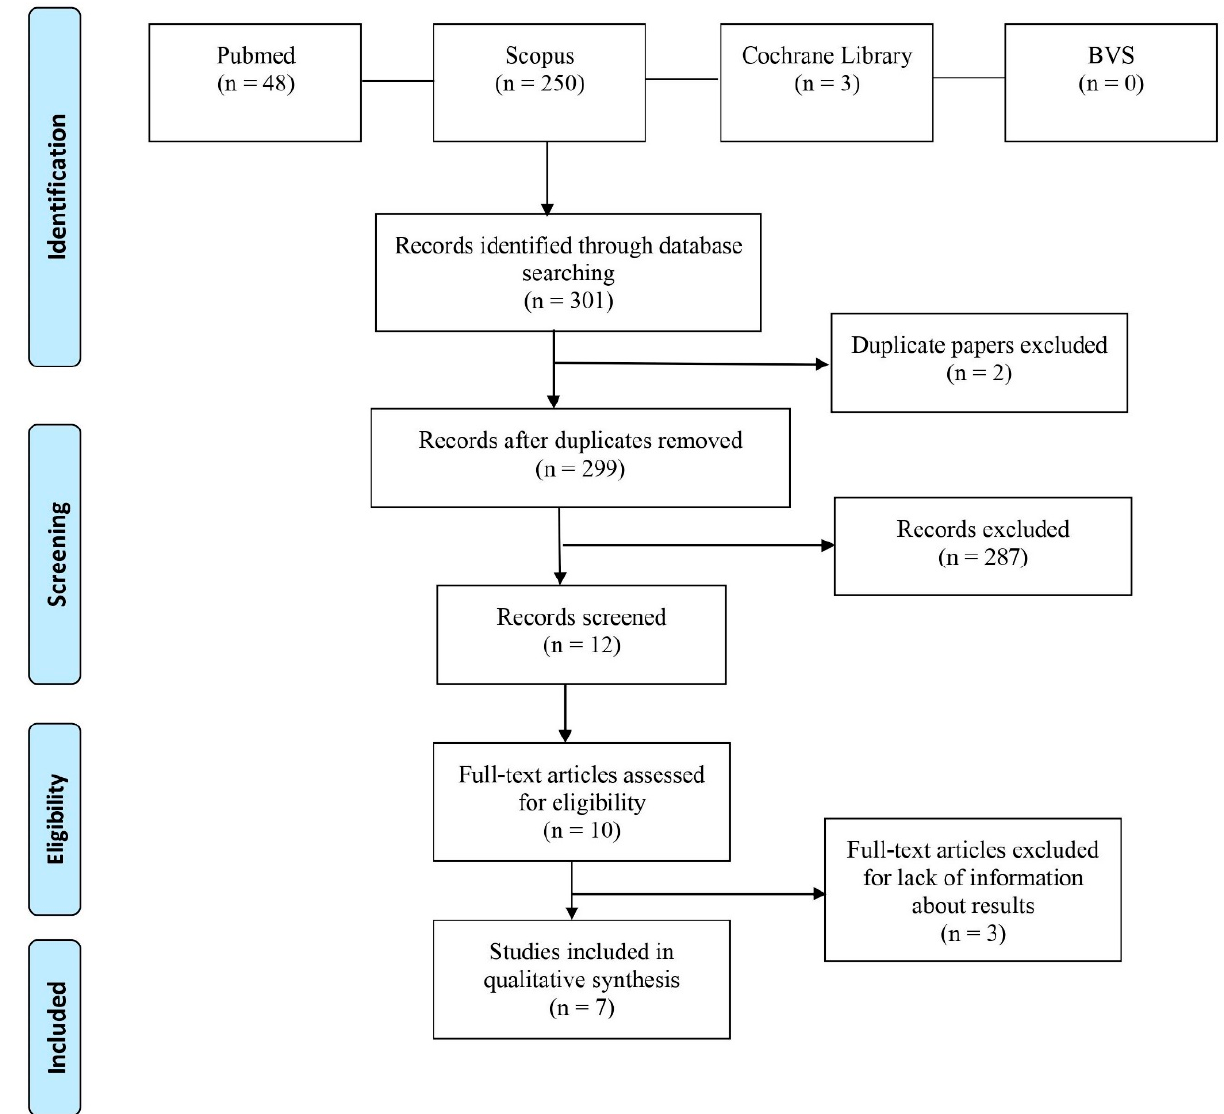
Figure 7. Prisma flow diagram.